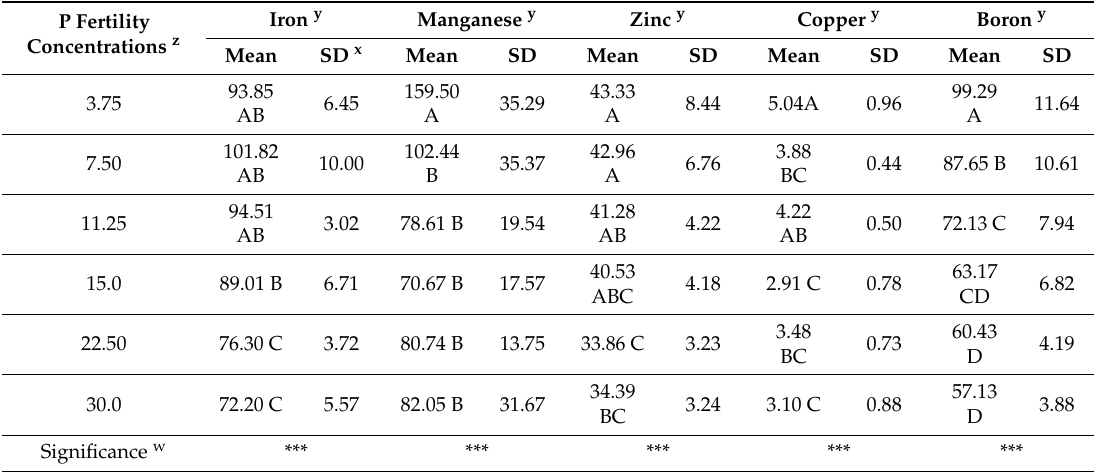
Table 4. The impacts of phosphorus (P) fertility on micronutrient accumulation in leaf tissue of C. sativa “BaOx” after eight weeks of vegetative growth.